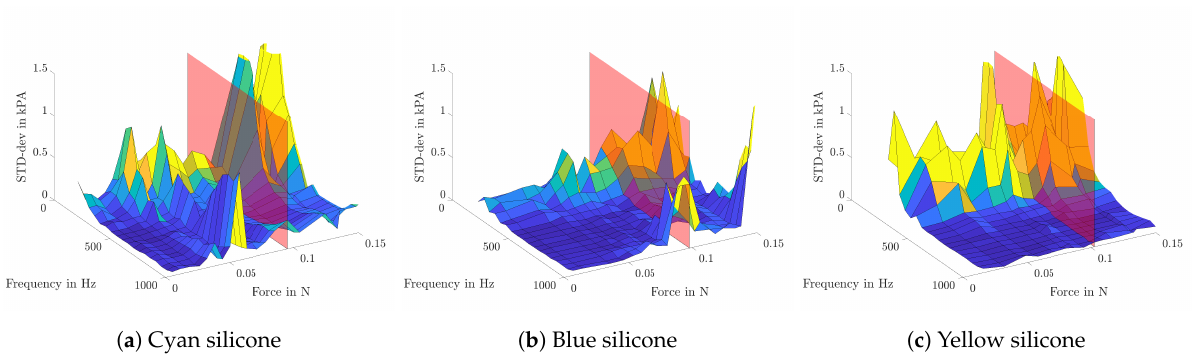
Figure 9. For different pipette contact pressures, the standard deviations (STD-dev) of the elasticity measurements are plotted against the applied frequency. The red plane tags the contact force of about 0.1N, which was chosen. The results for the cyan, blue and yellow silcone are shown in subfiguire ( a – c ).